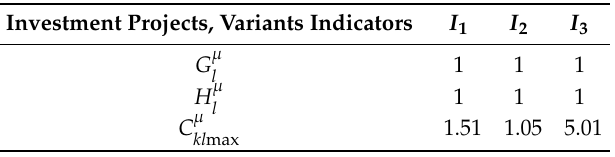
Table 5. Matrix of